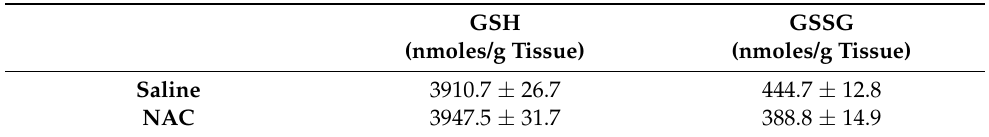
Table 1. Brain levels of GSH and GSSG after subchronic NAC (100 mg/kg per day) administration. Data are the mean ± SEM ( n = 10 per group). No significant group differences were observed (Mann–Whitney test).